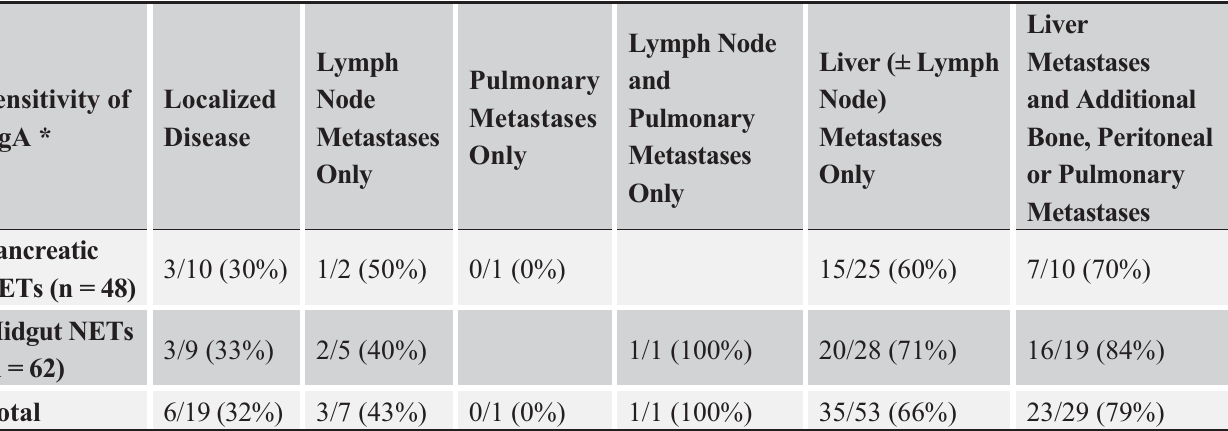
Table 4. CgA sensitivities (number of patients with median CgA values above reference range/number of all patients of the corresponding group) depending on metastatic spread and tumor